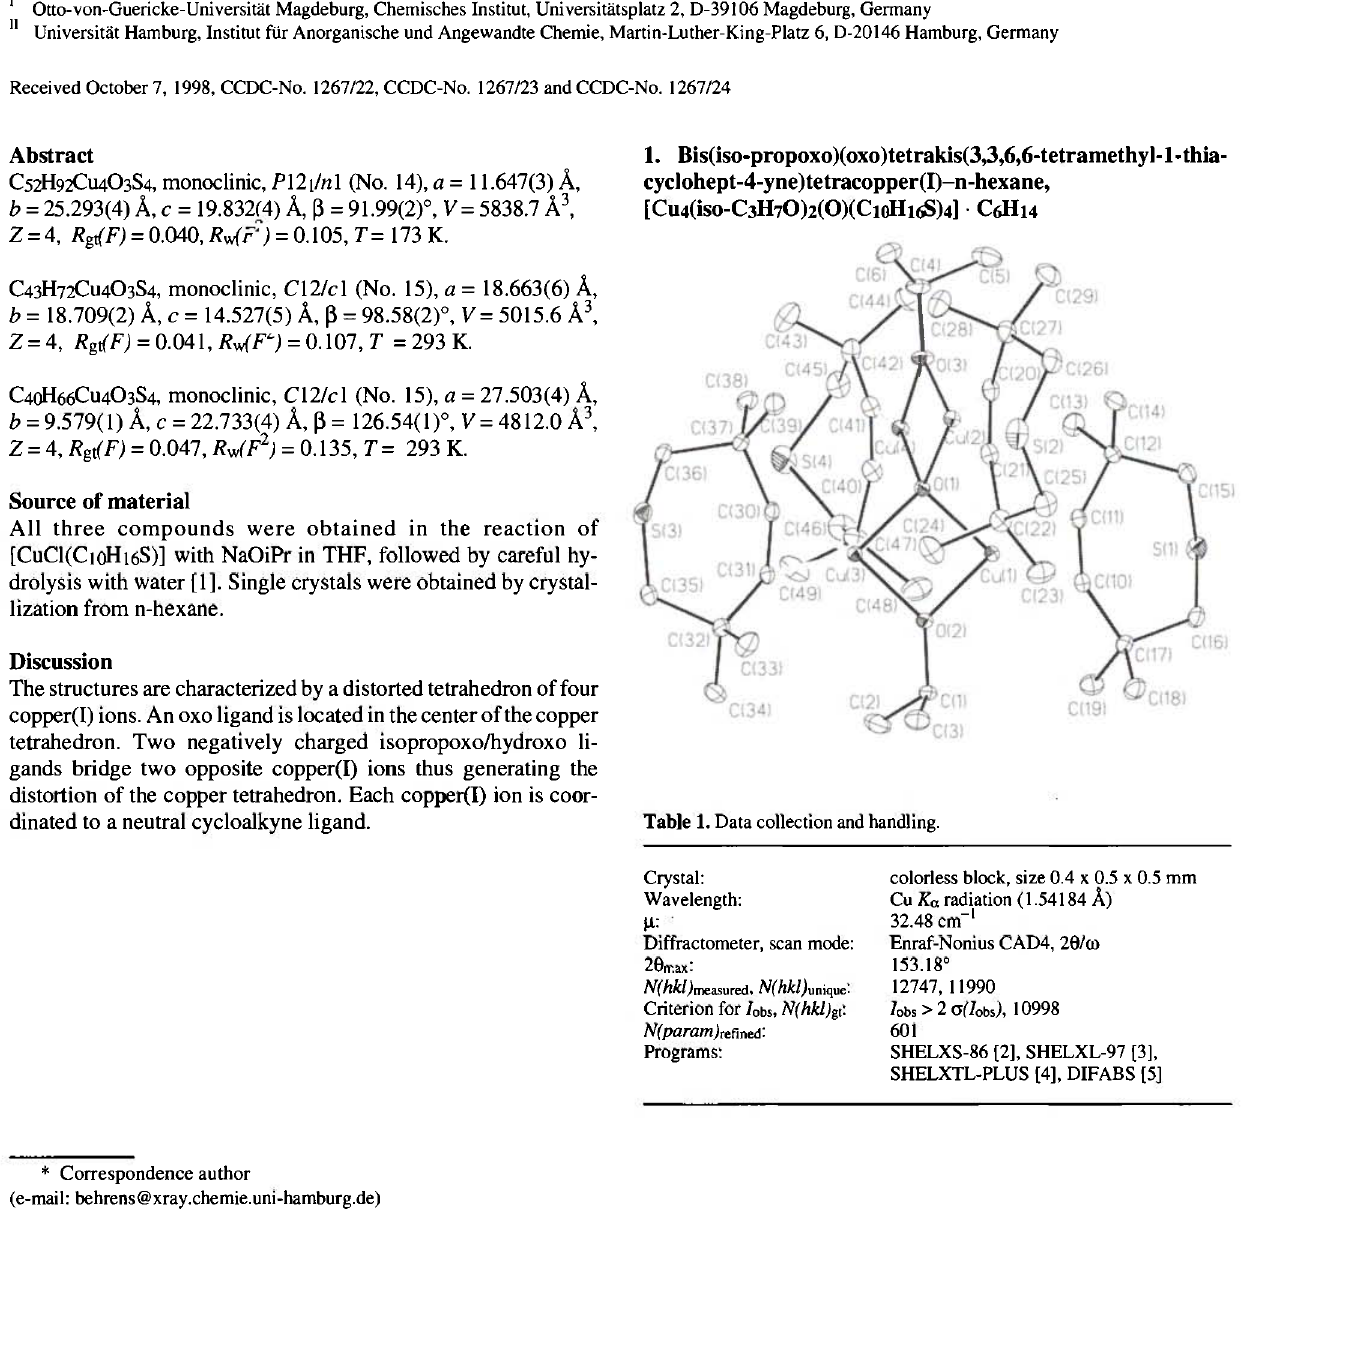
Table 1. Data collection and